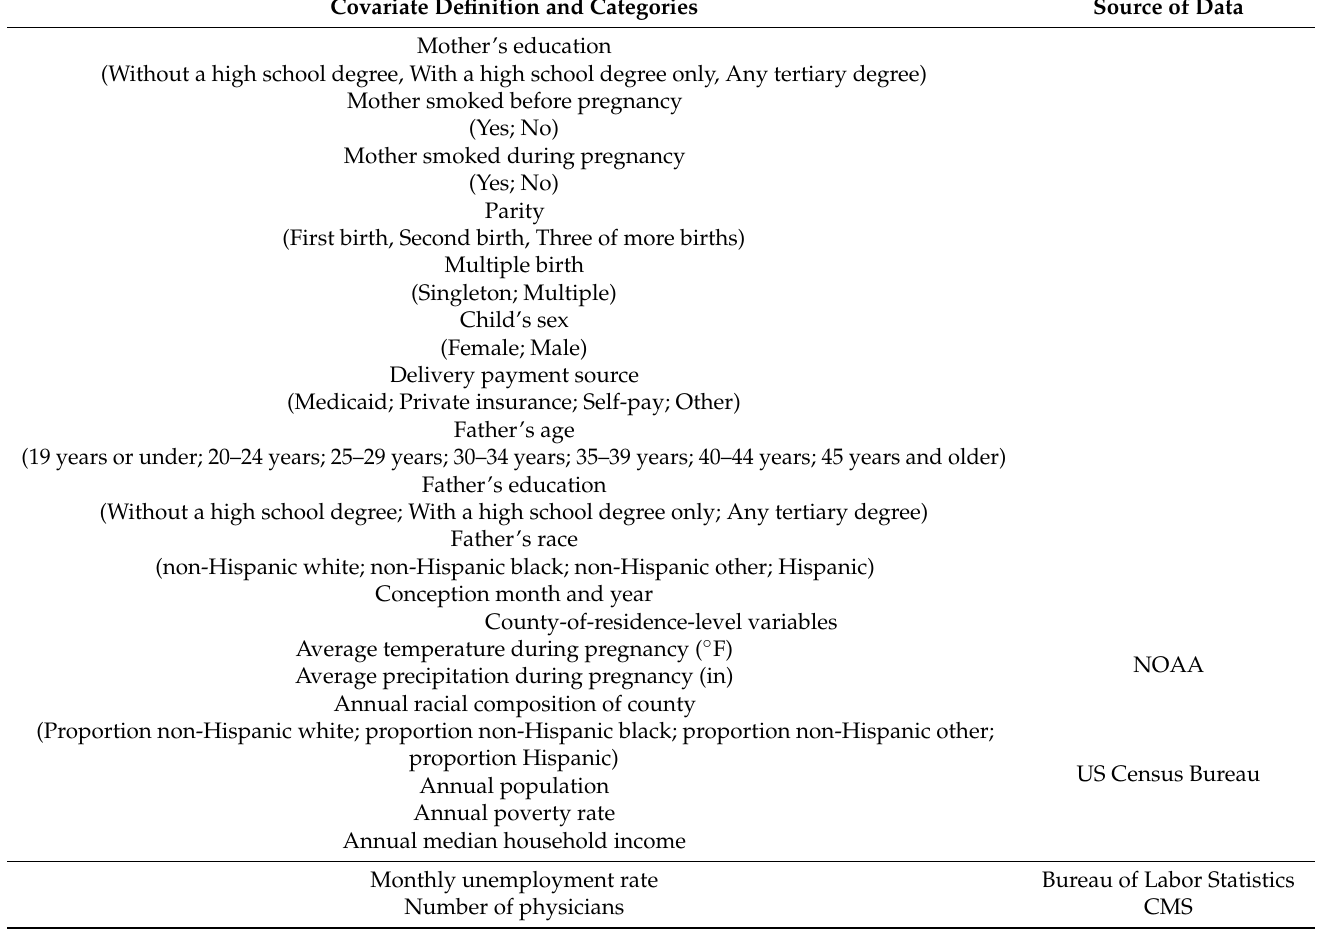
Table A1. Cont. Covariate Definition and Categories Source of Data